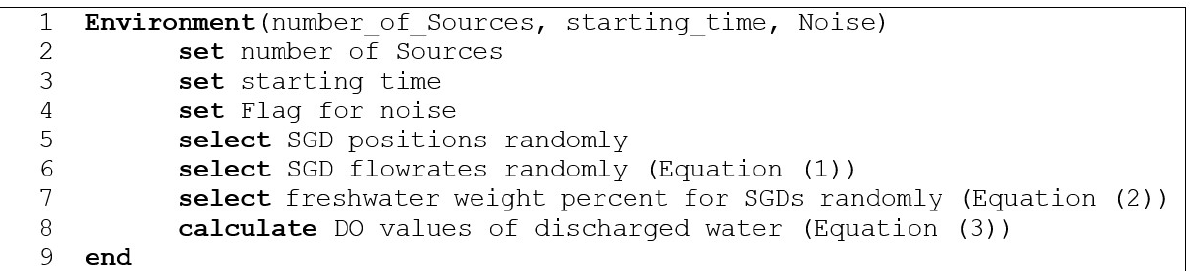
Figure 6. Pseudocode constructor of environment class.